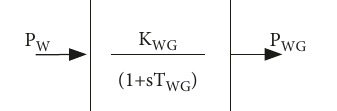
Figure 3: Modeling of wind generation.